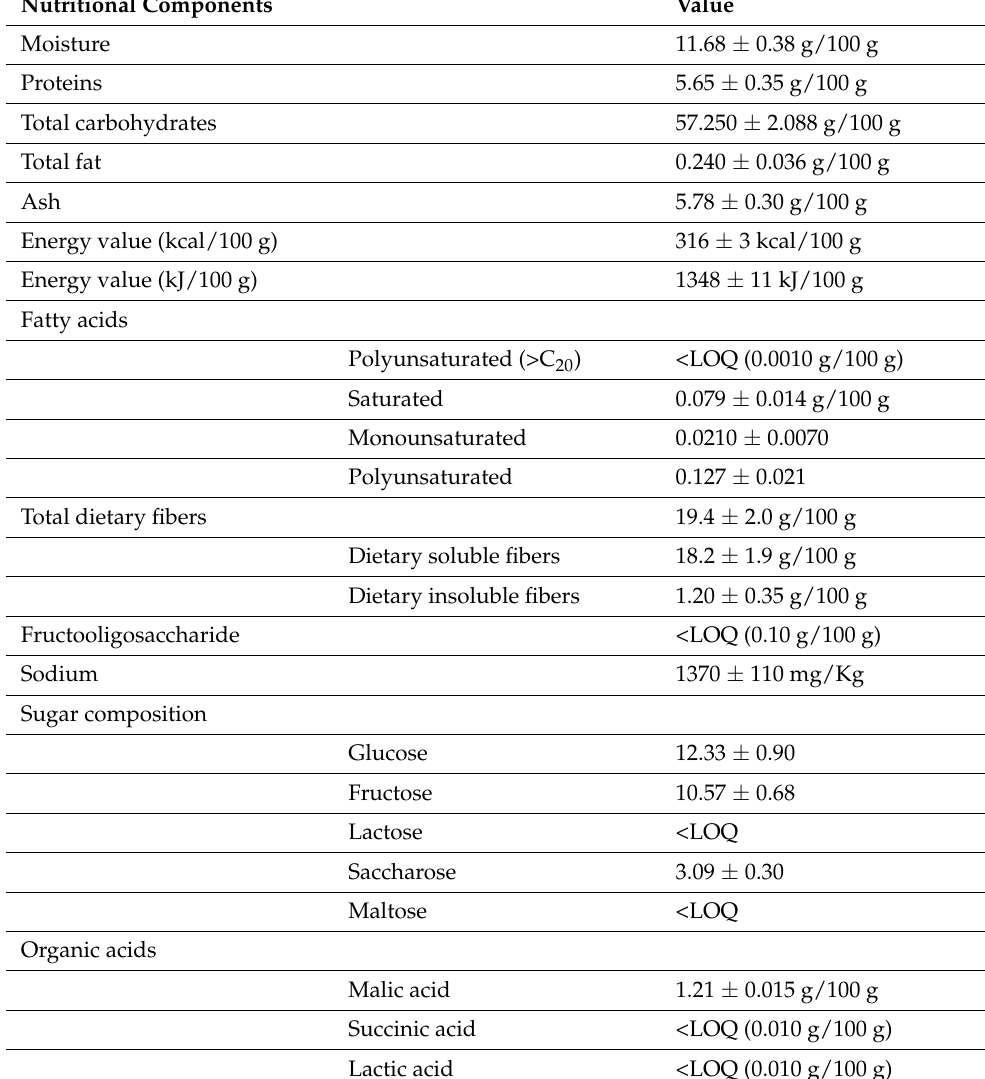
Table 1. PBJ nutrients composition and energy values. Nutritional